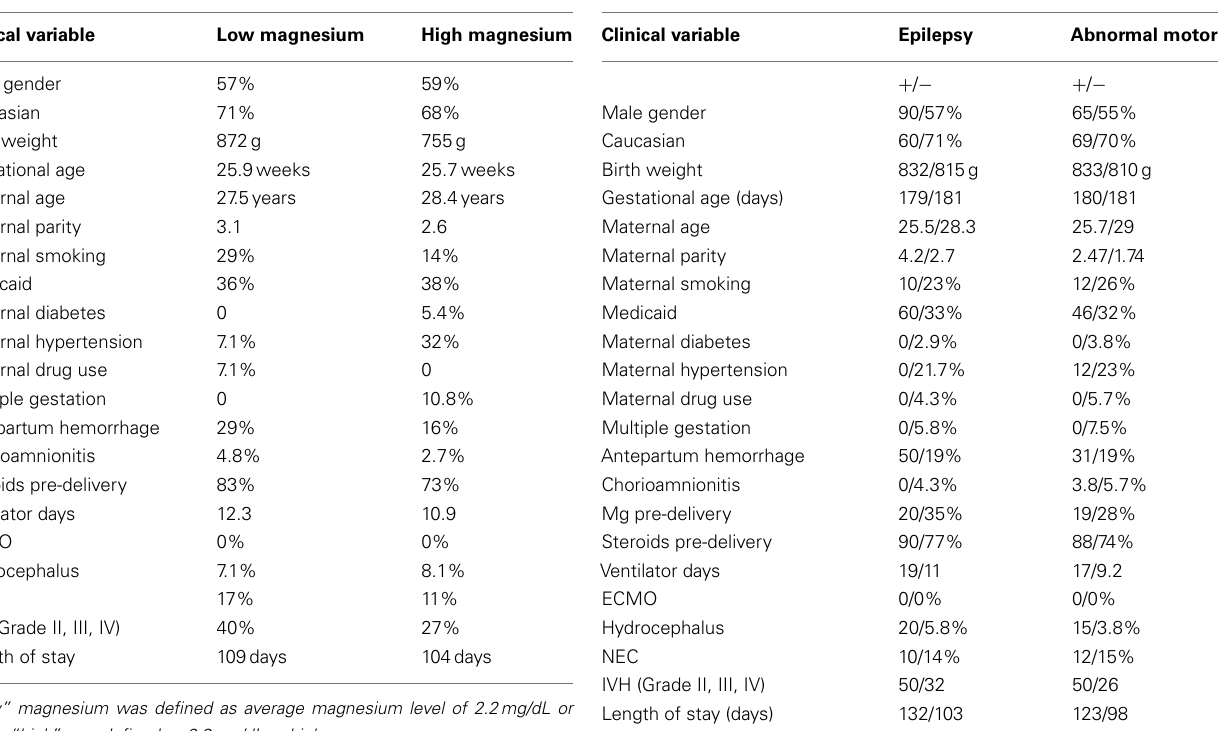
Table 7 | Comparison of clinical variables and the outcomes for epilepsy or abnormal motor exam